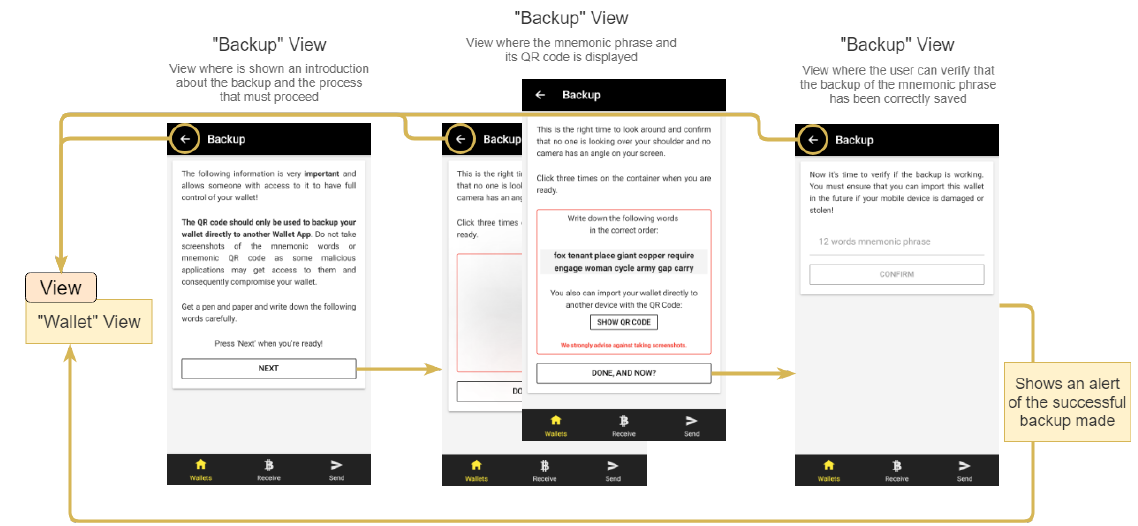
Figure 9. Navigability diagram of the process of backing up a wallet.